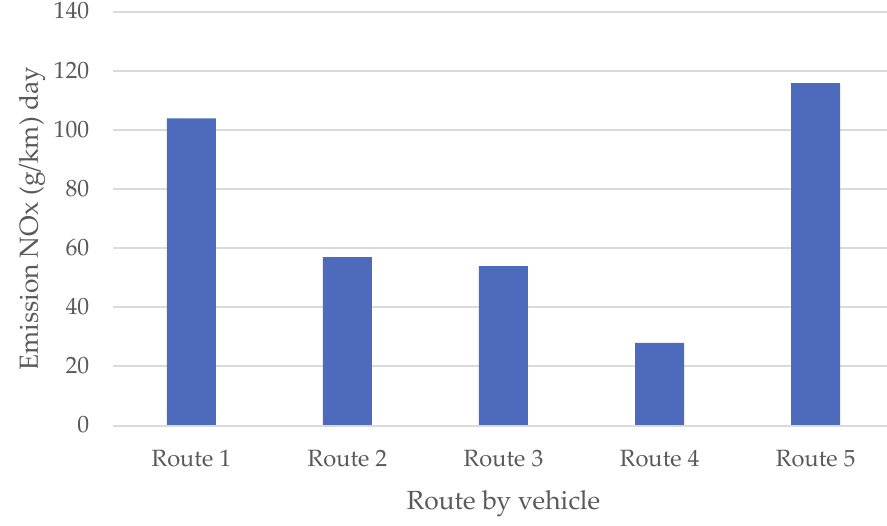
2.5 of the different routes.